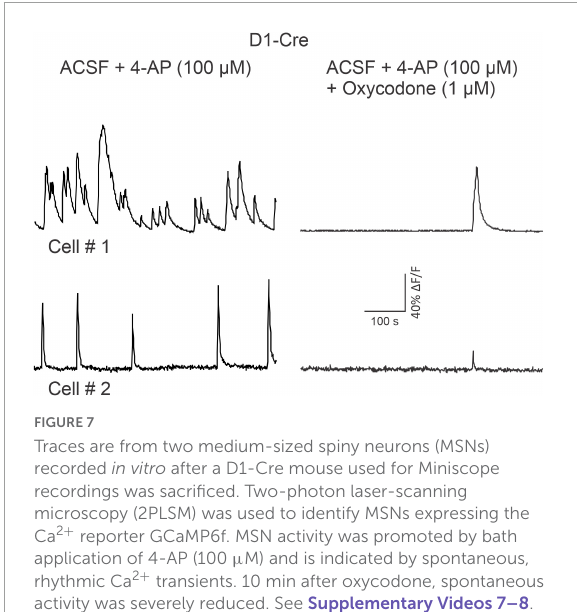
FIGURE7 Traces are from two medium-sized spiny neurons (MSNs) recorded in vitro after a D1-Cre mouse used for Miniscope recordings was sacrificed. Two-photon laser-scanning microscopy (2PLSM) was used to identify MSNs expressing the Ca 2 + reporter GCaMP6f. MSN activity was promoted by bath application of 4-AP (100 µ M) and is indicated by spontaneous, rhythmic Ca 2 + transients. 10 min after oxycodone, spontaneous activity was severely reduced. See Supplementary Videos 7–8